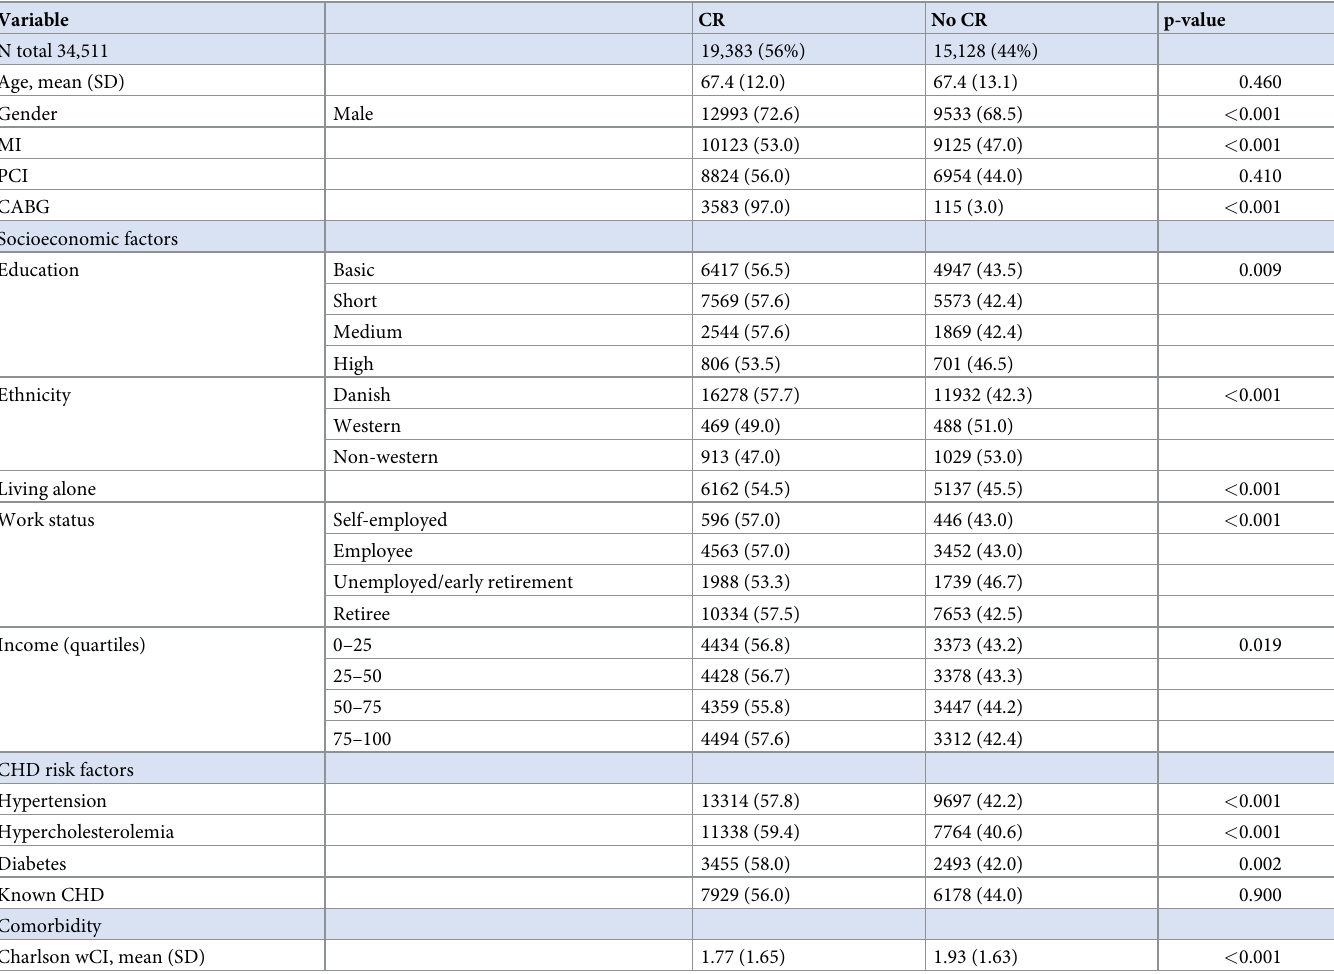
Table 3. Demographic characteristics, socioeconomic factors, and comorbidity CR participation among 34.511 patients in the DNPR